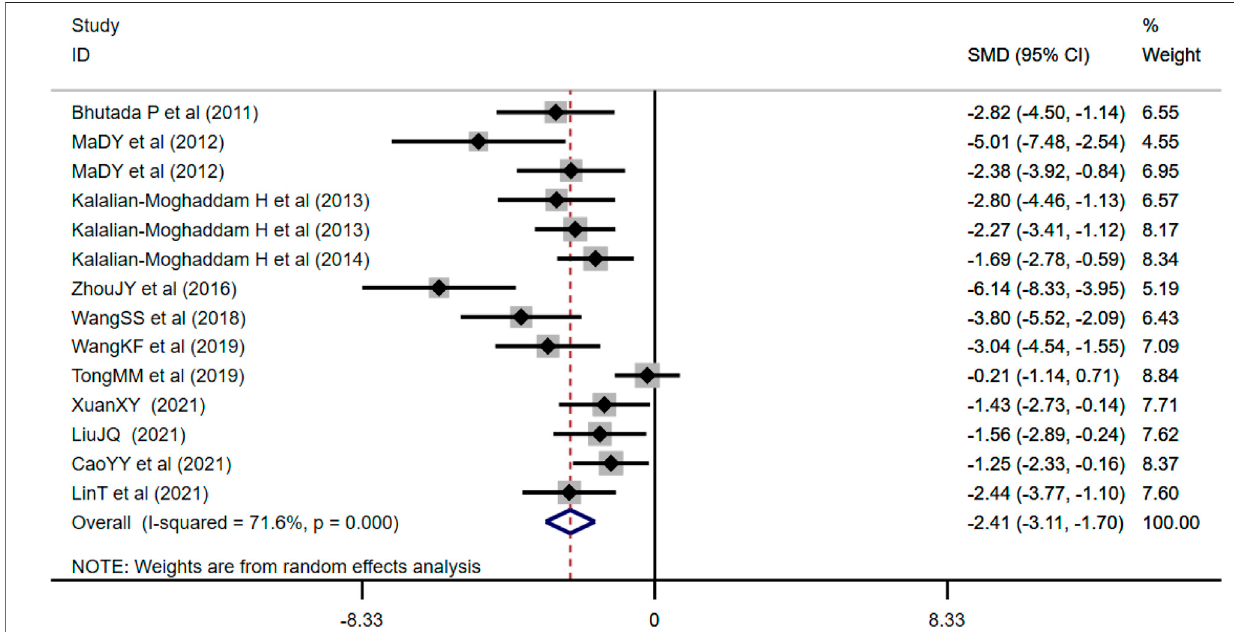
FIGURE 3 | Forest plot: effect of berberine on FBG